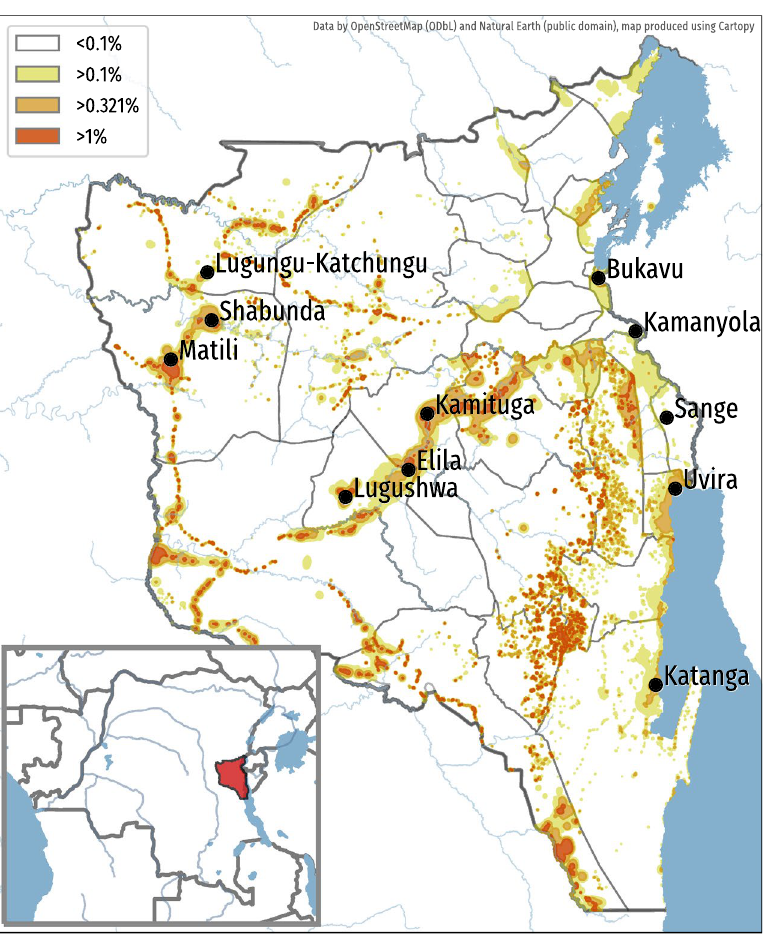
Figure 1. Mapping of TB predicted incidence rate for the South-Kivu province of the Democratic Republic of Congo (inlay). No color: below 0.1%; Yellow : between 0.1% and national average (0.322%); Orange : between 0.322% and 1%; Red : above 1%. Geospatial data provided by OpenStreetMap (under ODbL license) and Natural Earth (public domain), map produced using Cartopy v0.20 from https:// scito ols. org. uk/ carto py.